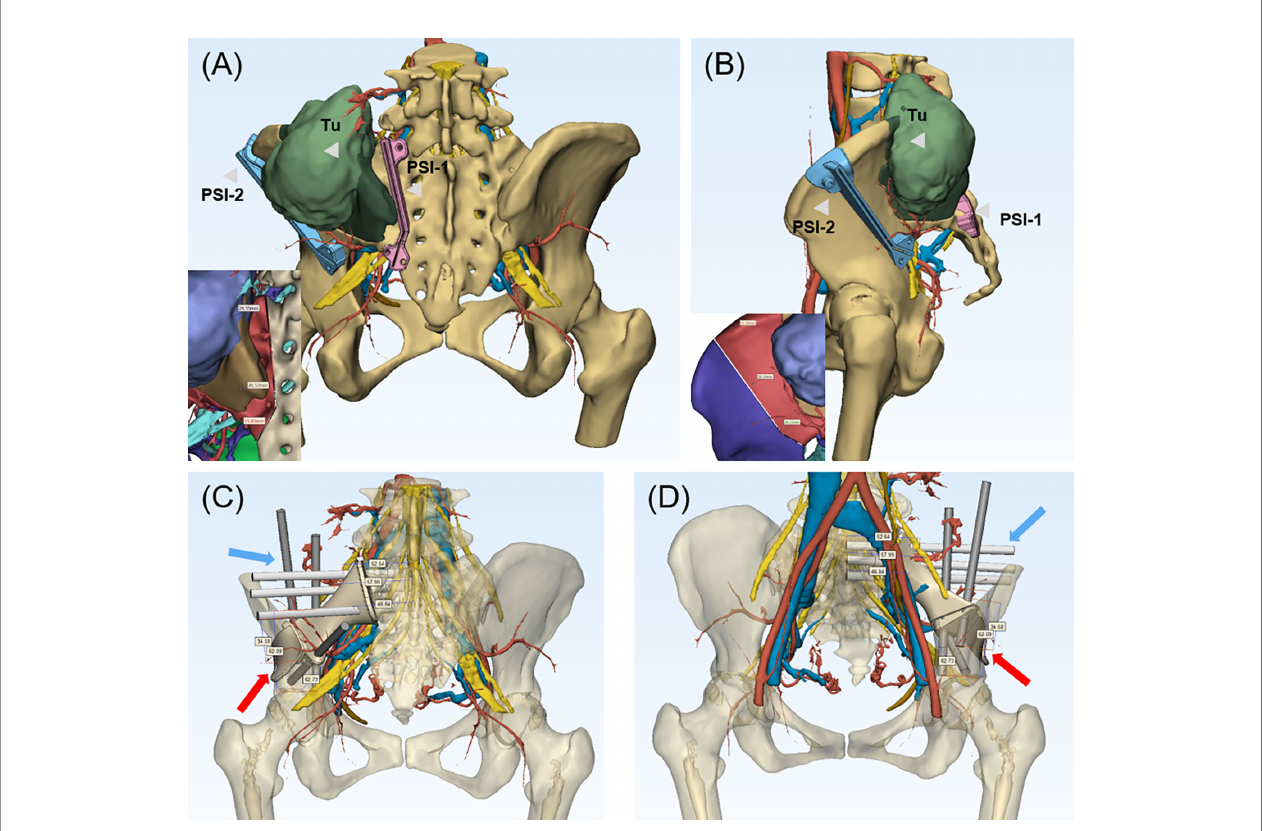
FIGURE 2 | (A, B) 3D-multimodality image of tumor model with PSI and surgical margin designed. The PSI-1 was placed on the sacral ala adjacent to sacral foramina and PSI-2 was placed on ilium with a adequate margin designed. The neurovascular structure were clearly shown to avoid intraoperative damage. In the left bottom, the purple region represented tumor, and the brown region represented the tumor edema with details of neurovascular structures, which guaranteed the accuracy of the resection. (A) (Posterior view), (B) (Lateral view). (C, D) The endoprosthesis and screw fi xation design with the length of screws shown on the 3DMMI of the patient after tumor resection. The screws in the sacral side was expected to reach the middle line of sacrum and the residual ilium was crossed fi xed with the screws of the ilium side. The blue arrow indicated the screws and the red arrow indicated the endoprosthesis. PSI, patient-speci fi c instrument; Tu,